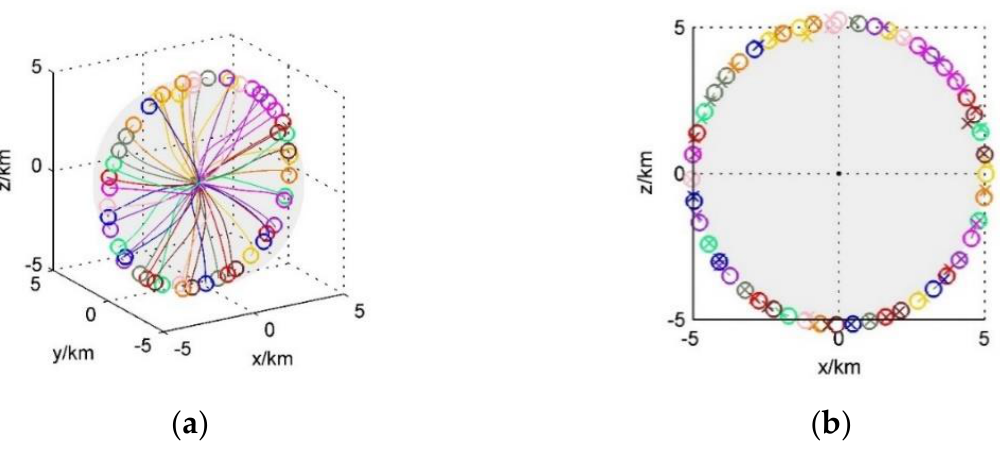
Figure 16. The in-plane circle formation ( r = 5 km, µ = − 5 km). ( a ) Relative motion trajectory in 0-1000 s; ( b ) Relative motion trajectory in 1000–2000 s. Figure 17 shows the motion trajectory of the satellite cluster to establish in-plane concentric double circle formation with the radius of 1.5 km and 0.5 km in the target orbital frame.